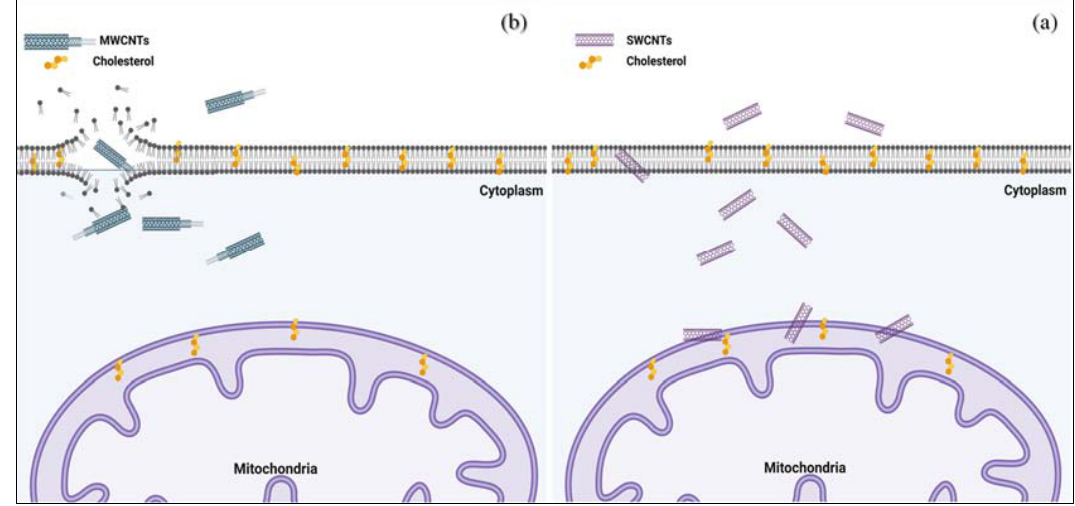
Figure 3. Schematic description of interaction of SWCNTs ( a ) and MWCNTs ( b )with cell membrane and mitochondria (based on reference [53]). Table 2. Studies evaluating the therapeutic impact of CNT complexes on breast cancer cells.